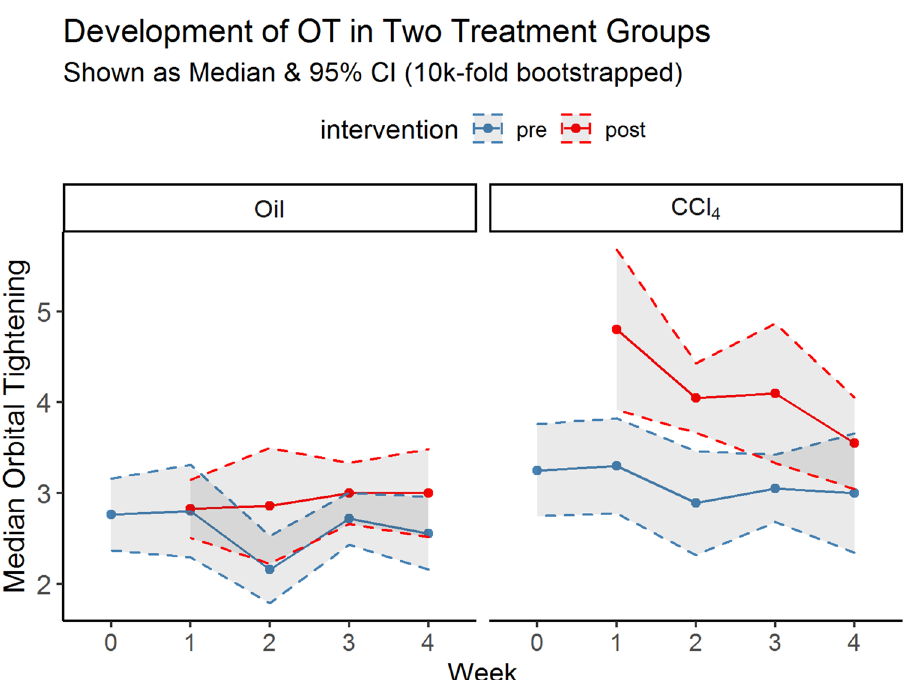
Figure 5. Bootstrapped (10 k-fold) estimates of the OT score in the two treatment regimens are shown as medians with 95% CI bands. The estimates in the control group showed no significant differences over time (overlapping confidence bands). There was also no difference regarding the intervention. In the CCl 4 group, there were multiple differences in Orbital Tightening concerning the baseline values (week 0), time, and interventions. Intervention peaks in week 1, followed by a continuous return towards the untreated levels (negative slope) in week 4 as indicated by model